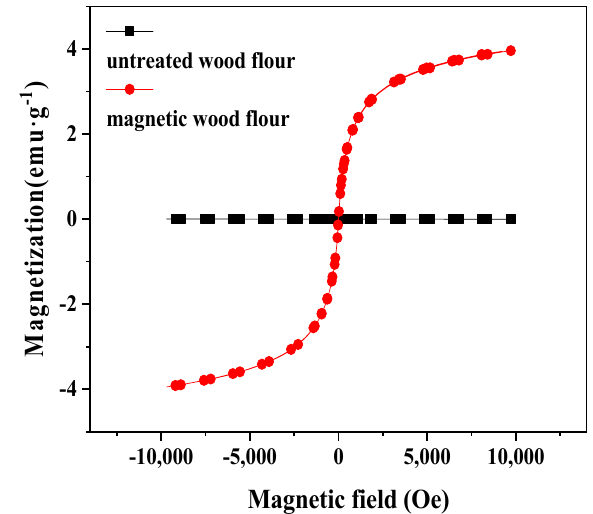
Figure 4. Magnetic hysteresis curves of the pure wood flour and the magnetic wood flour.